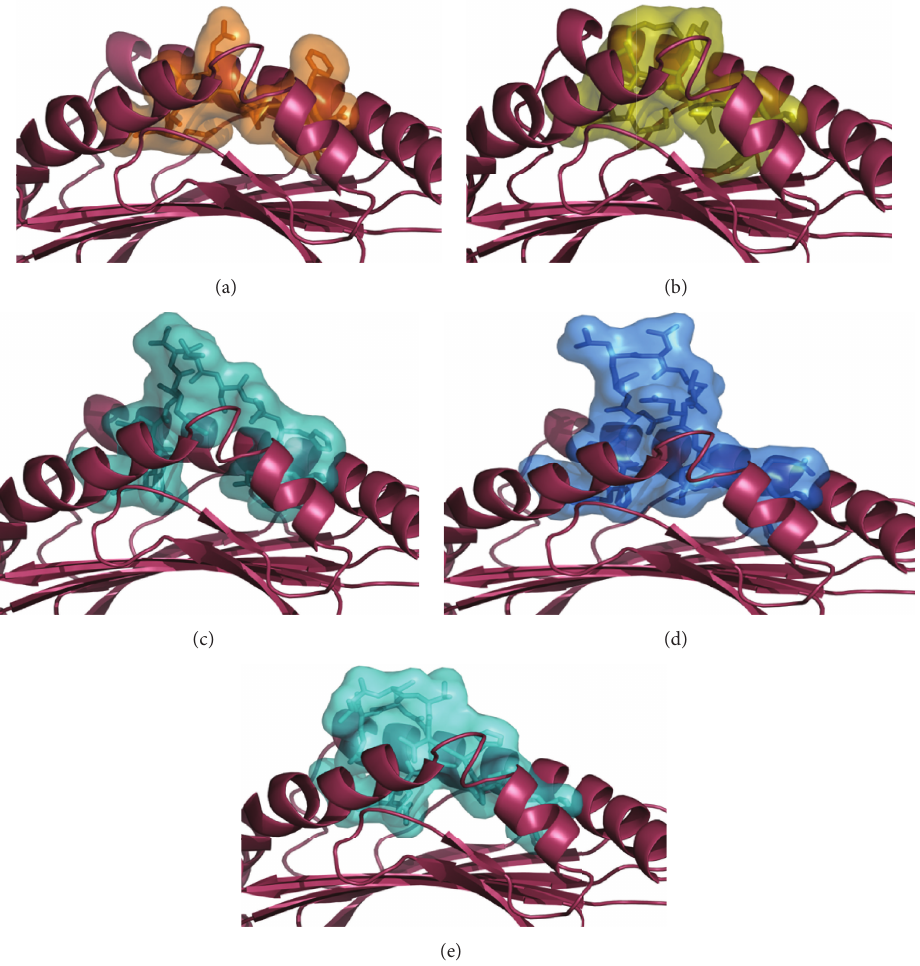
Figure 4: Models of noncanonical self-peptides bound to HLA-E show highly diverse confirmation resulting in distinct accessible surface areas. (a) The HLA-E crystal structure with the VMAPRTLFL (orange) peptide (PDB: 3CDG) was used as a template for modelling the peptides into the PBR of the HLA-E molecule (raspberry). (b) The SKGKIYPVGY (olive) peptide shows only minimal surface area that protrudes out the PBR compared to (c) DVHDGKVVSTHEQ (teal) that strongly forms a bulgy structure that provides large parts of its accessible surface to solvent. This is also the case for the peptides (d) LGHPDTLNQGEFKEL (marine blue) and (e) LVDSGAQVSVVHPNL